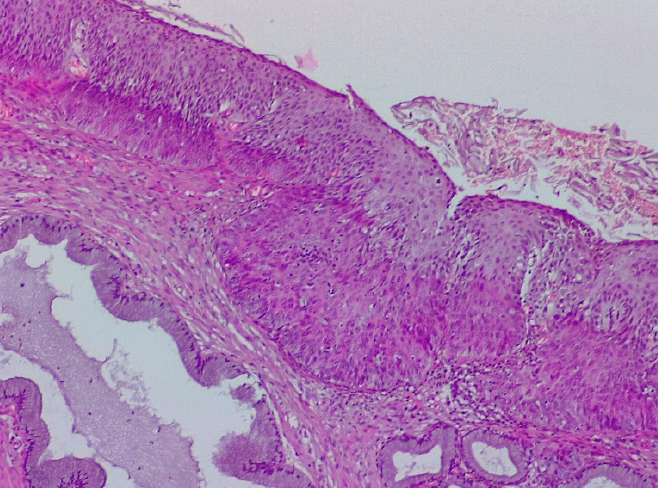
Figure 11. Image showing three typical aspects of CIN in the case in Figure 8: squamous abnormalities and glandular dilatations as well as moderate ulceration of the squamo–cylindric junction with anisocoria and nuclear polymorphism. (Hematoxylin–eosin 10×.)